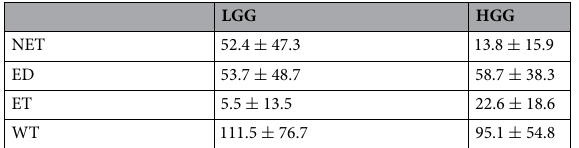
3 ] according to each tumor regions